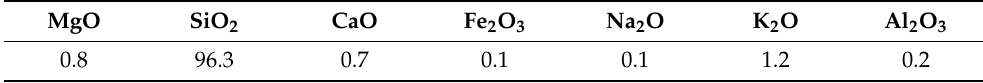
Table 5. Component of silica fume (%).